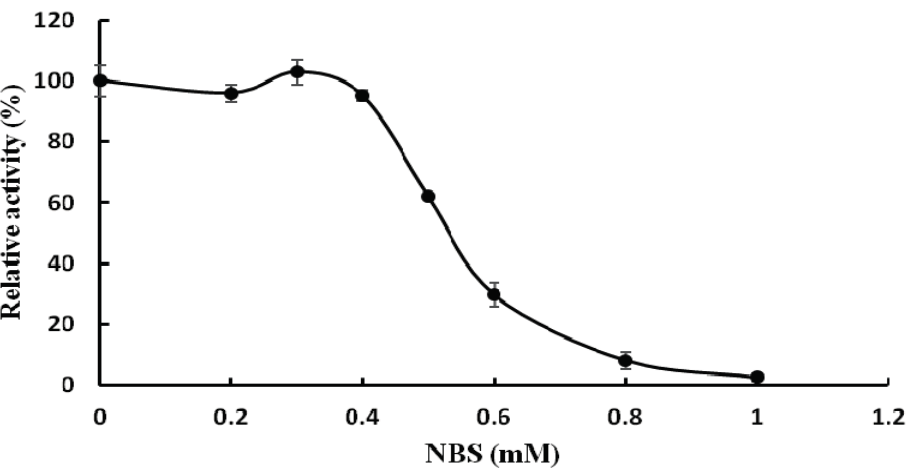
Figure 3. Effect of the chemical modification reagent N -bromosuccinimide (NBS) on activity of Tricholoma matsutake α -galactosidase (results represent mean ± SD, n = 3).